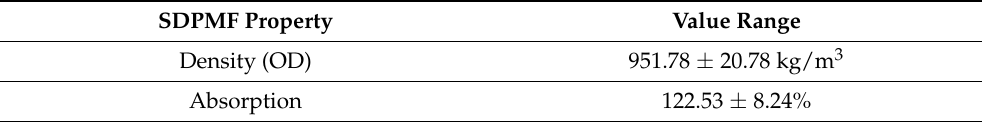
Figure 6. Effects of SDPMF content on the workability. 3.2.2. Effects of SDPMF Content and 10% SF Figure 7 shows the effects of SDPMF content and 10% SF on mortar workability. The workability losses of 30.43%, 35.28%, and 40.55% were recorded for M1S10, M2S10, and M3S10, respectively. With the 10% SF partial replacement of cement, the workability be- came lower as compared to SDPMF’s mortars containing no SF. This is due to the micro size and high fineness of SF that demands high content of water, leading to mixing water loss [39,40].